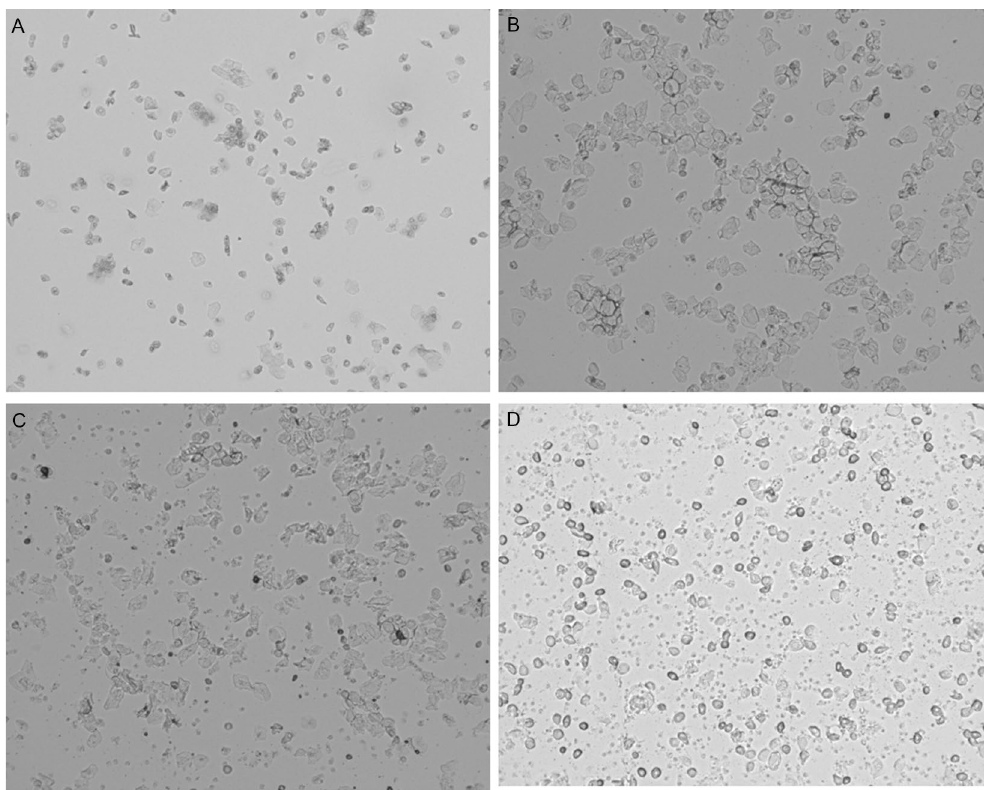
Figure 3. Representative vaginal lavage samples. Panels display samples rated as ( A ) proestrus, ( B ) estrus, ( C ) metestrus, and ( D )